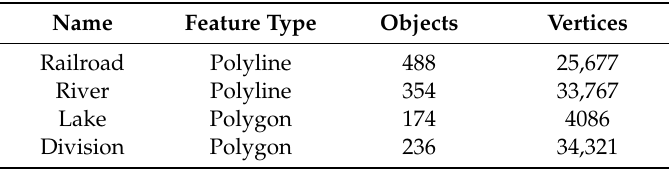
Table 1. Detailed information of the vector